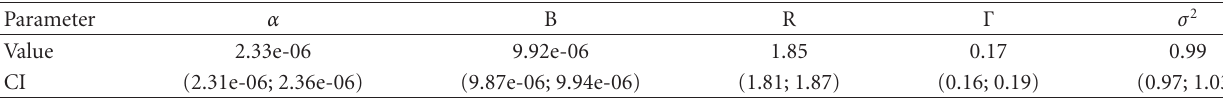
Table 7: Estimated values of parameters with confidence